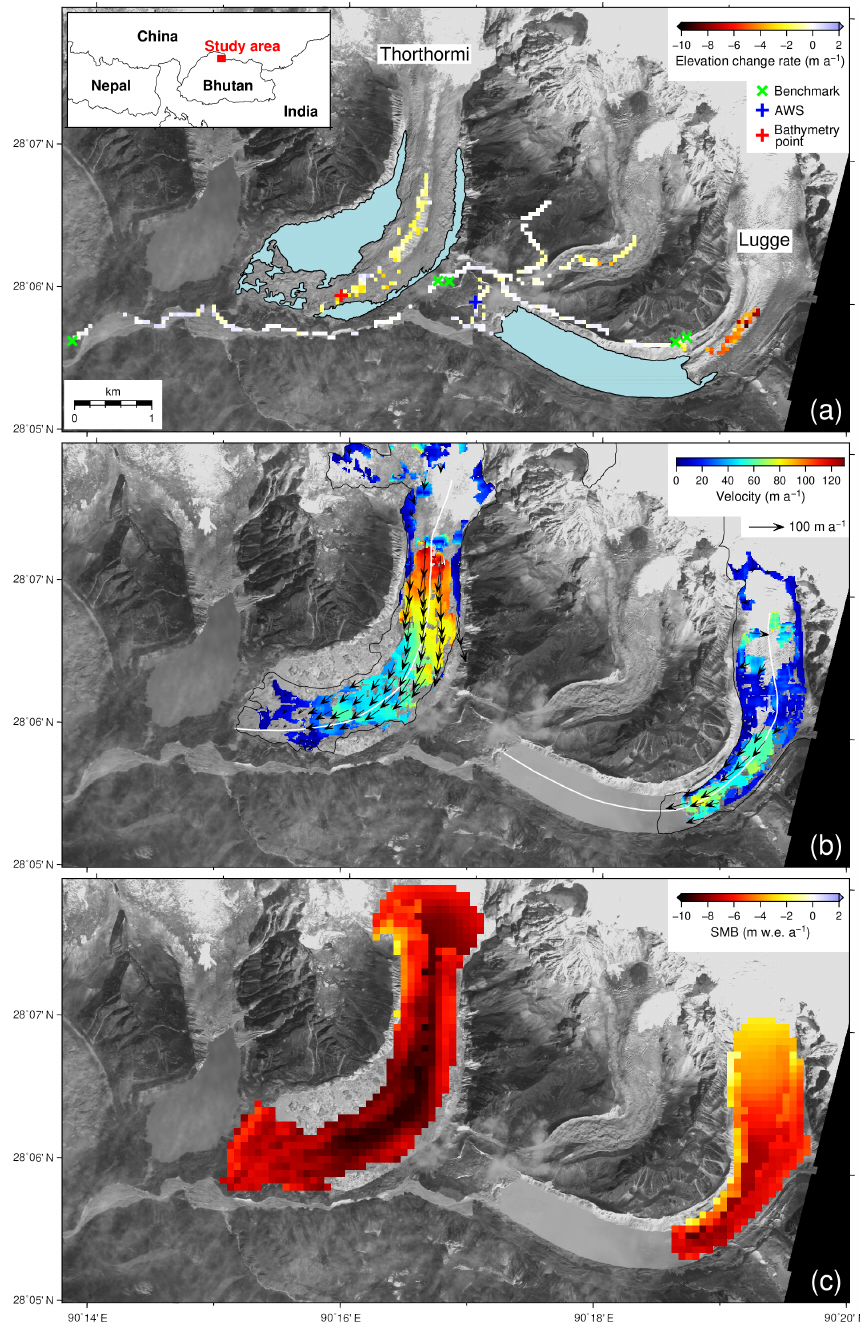
Figure 1. Glaciers and glacial lakes in the Lunana region, Bhutanese Himalaya, superimposed with (a) rate of elevation change ( (cid:49)z s /(cid:49)t ) for the 2004–2011 period derived from DGPS-DEMs, (b) surface flow velocities (arrows) with magnitude (colour scale) between 30 Jan- uary 2007 and 1 January 2008, and (c) simulated surface mass balance (SMB) for the 1979–2017 period. The inset map in (a) shows the location of the study site. The (cid:49)z s /(cid:49)t in (a) is depicted on a 50m grid, which is averaged from the differentiated 1m DEMs. Note that the bathymetry of Thorthormi Lake was measured at a limited point due to icebergs (red cross). Light blue hatches indicate glacial lakes in December 2009 (Ukita et al., 2011; Nagai et al., 2017). The background image is of the ALOS PRISM scene on 2 December 2009. The white lines in (b) indicate the central flow line of each